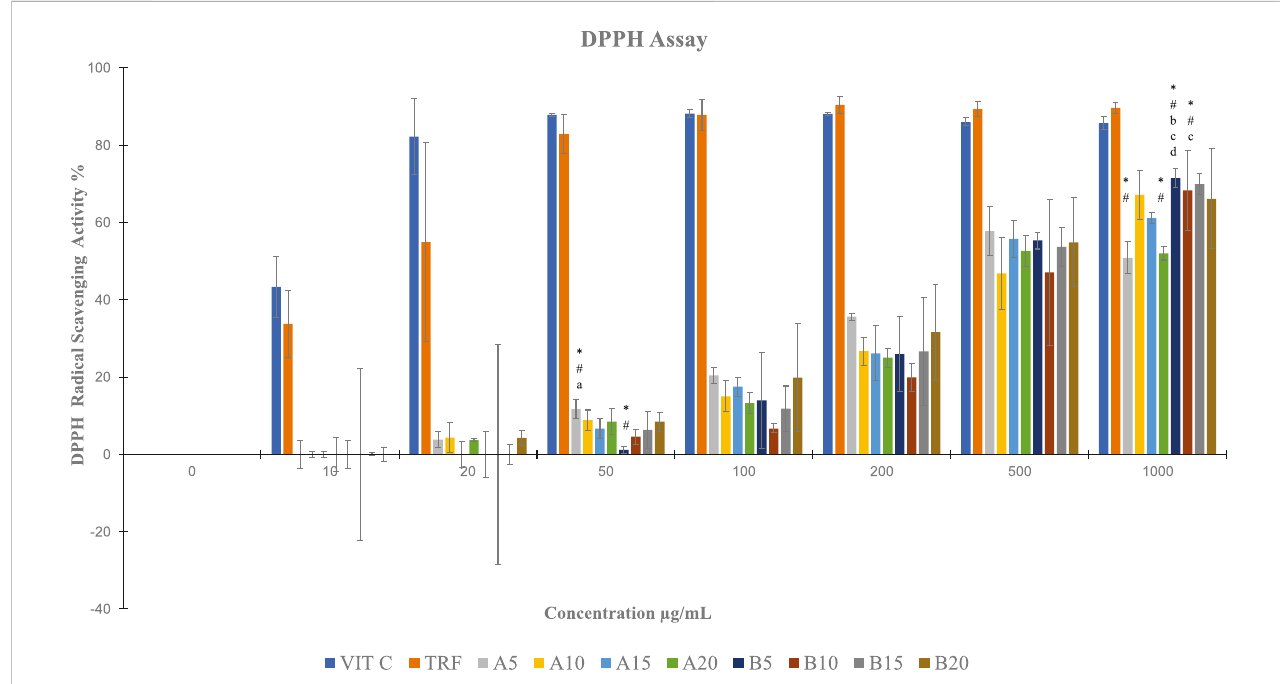
FIGURE 5 DPPHradicalscavengingactivityinbothsoilandsoillessginger.Datapresentedasmean±SD(n=3).A5,A10,A15andA20denotesoillessgingergroups. B5, B10, B15, B20 denote soil ginger groups, * p < .05 signi fi cantly different from Vit C, # p < 005 signi fi cantly different from TRF, a p < .05 signi fi cantly different from soil ginger at the same extraction time, b p < .05 signi fi cantly different from soilless ginger at the same extraction time, c p < .05 signi fi cantly different from A5 at the same extraction time, and d p < 0.05 signi fi cantly different from A20 at the same extraction